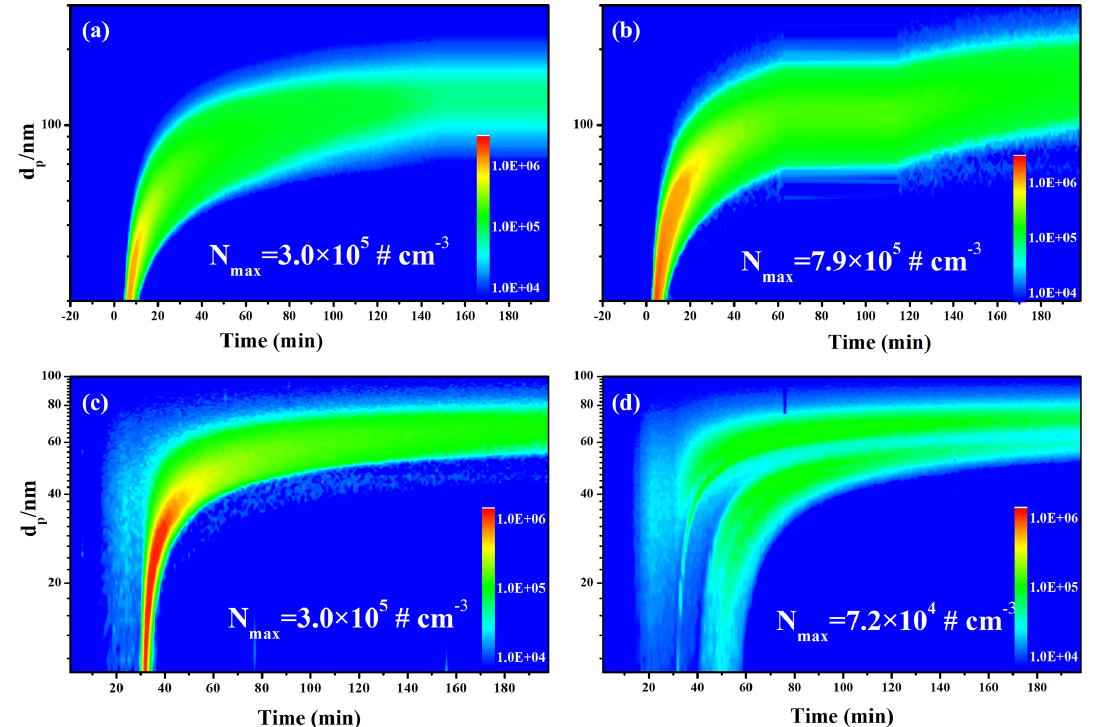
Figure 2. Size distribution of secondary aerosol as a function of time at 55ppb SO 2 (a) and 135ppb SO 2 (b) and under AS seed particle (c) and acidic AAS seed particle (d)